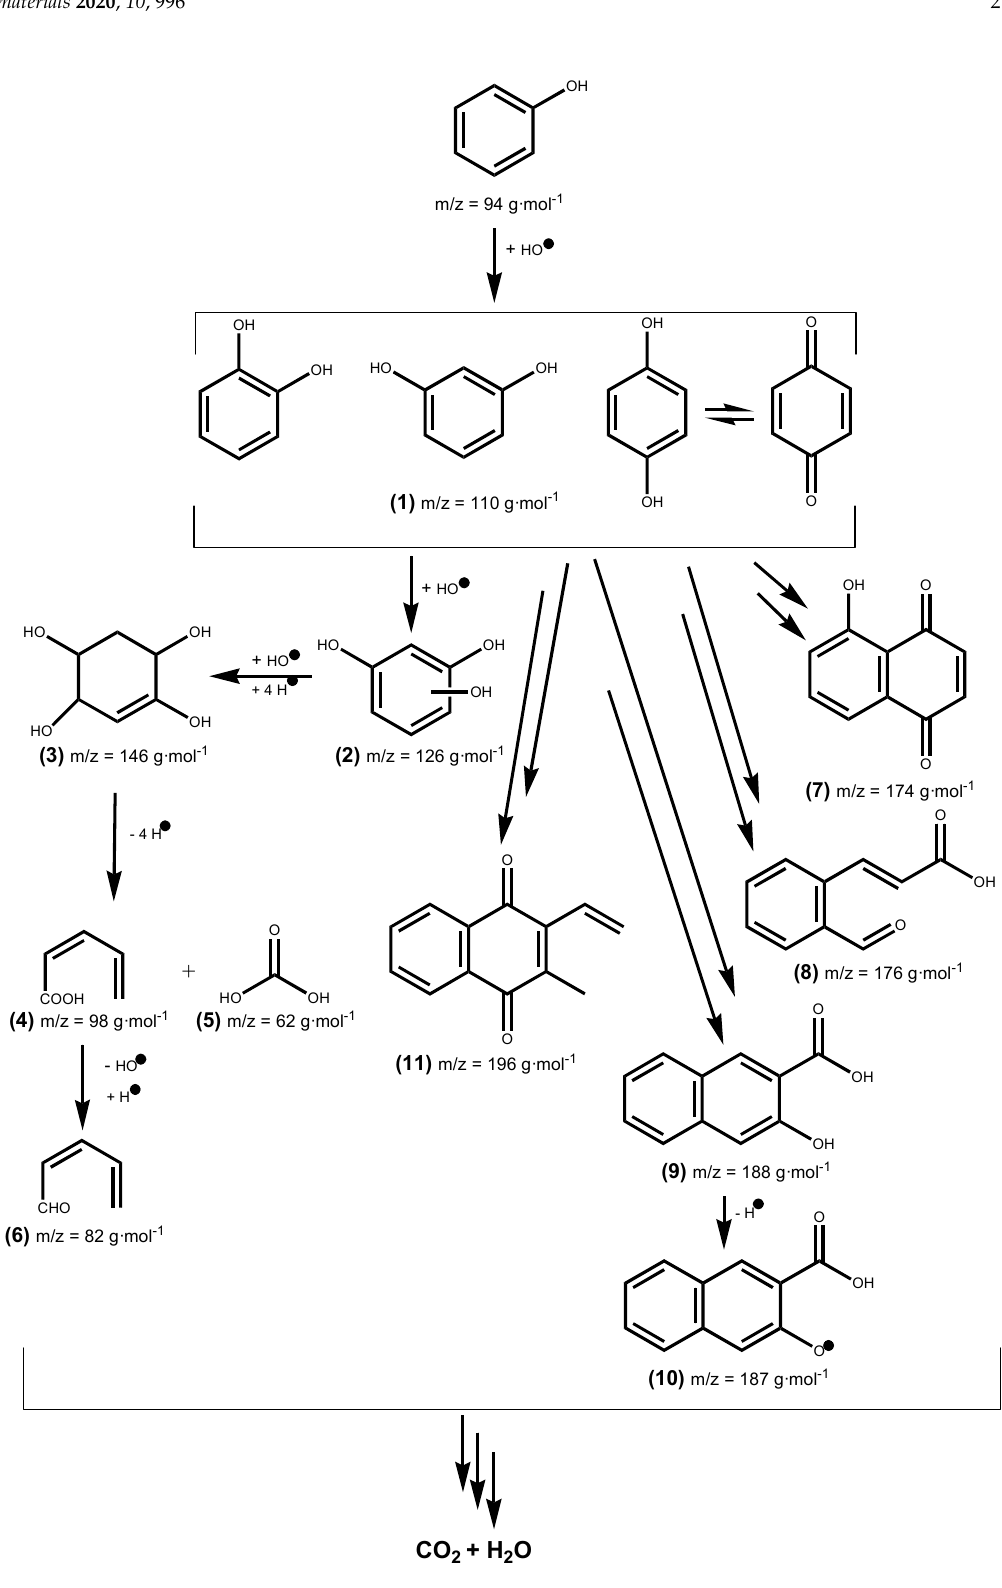
Figure 13. Proposed reaction pathways for the photocatalytic degradation of phenol over M/TiO 2 (M = Cu, V, and Cr) under UV and visible irradiation. m/z ratios are rounded here, exact values are given in Table 5.